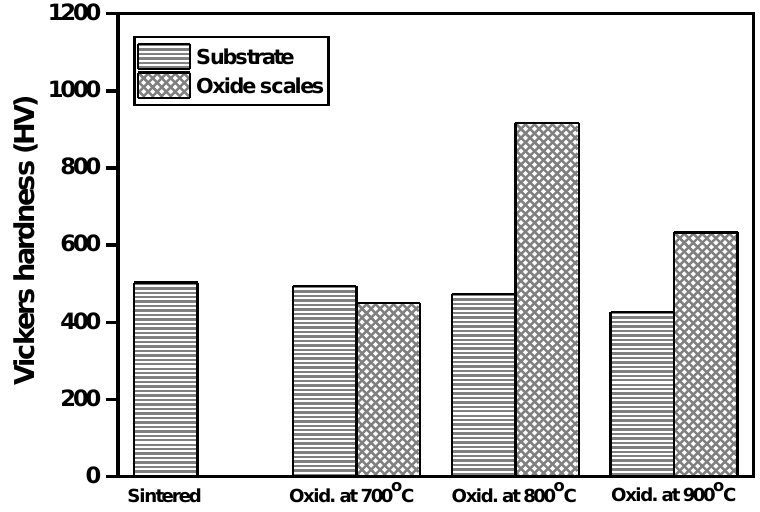
Figure 9. Hardness values of the Ti samples before and after oxidation.